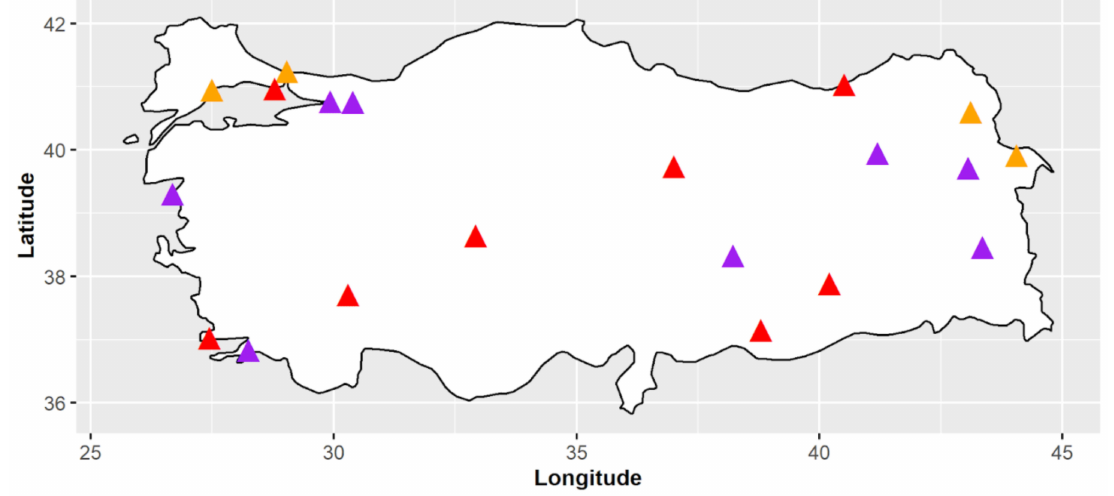
Figure A16. Same as Figure A13 but for March (See Figure A13 for